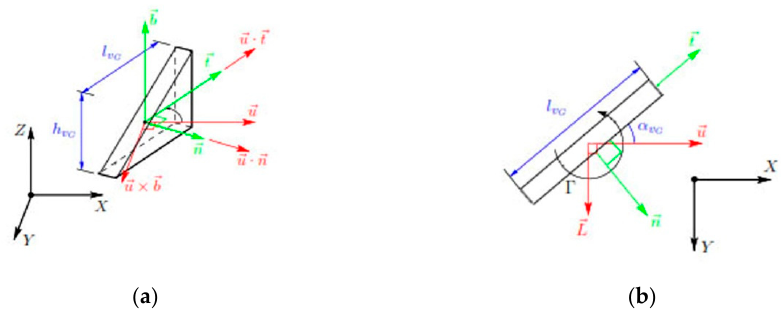
Figure 3. View of forces on a triangular vortex generator (VG): ( a ) side view and ( b ) top view.